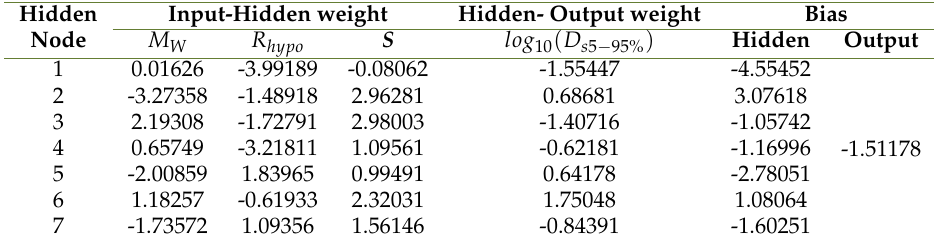
Table 2. Weights and biases of the 3-7-1 model.